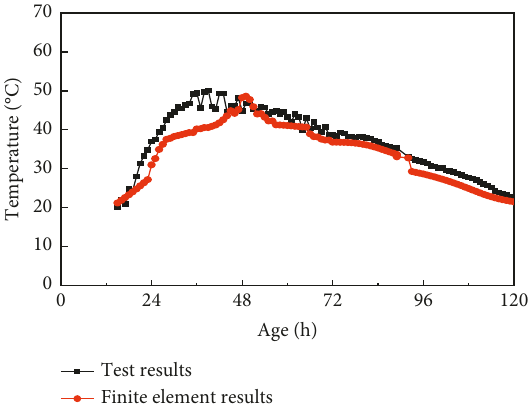
Figure 10: The temperature comparison in the top surface on the sunny side of the concrete in the center.